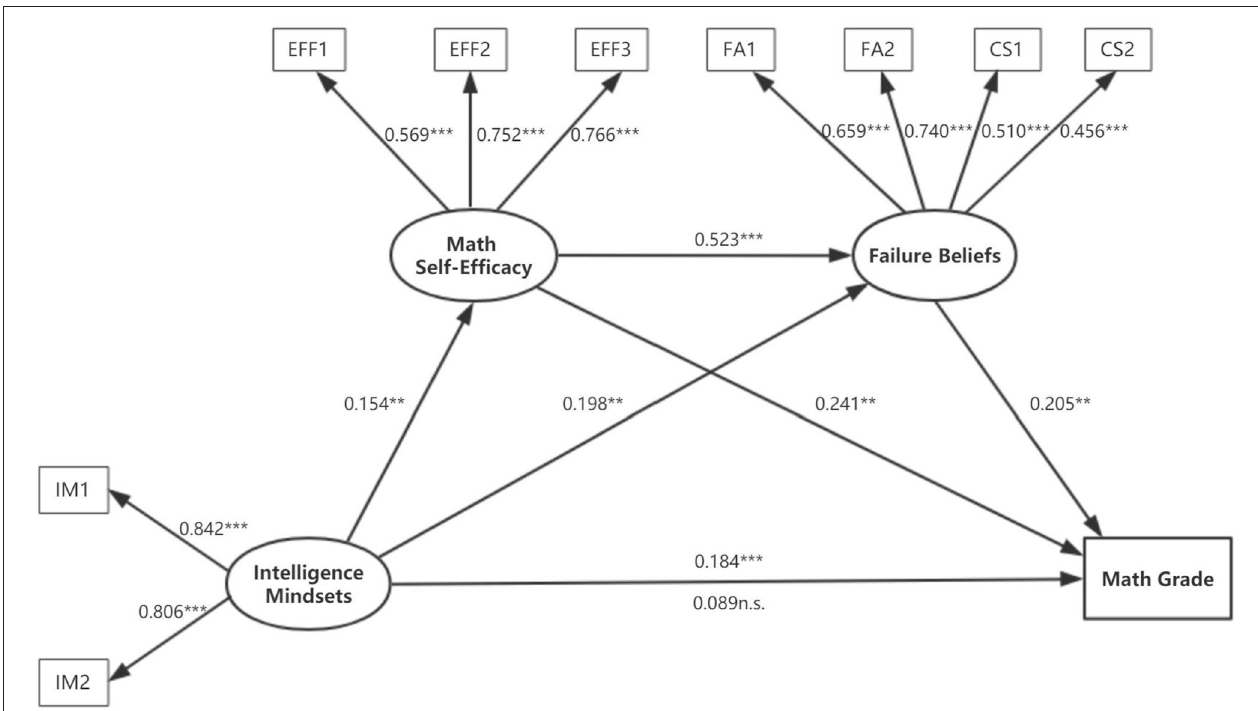
FIGURE 1 | Full model. Along the bottom path, the coefficient above the arrow indicates the direct effect, and the coefficient below the arrow indicates the effect with mediators. ** p < 0.01, *** p < 0.001.